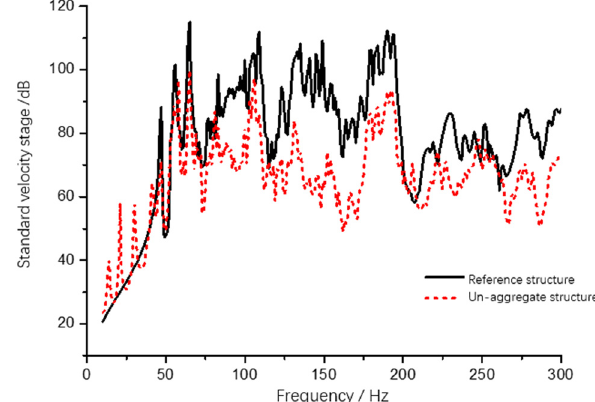
Figure 3: Mean square velocity of deck in cabin